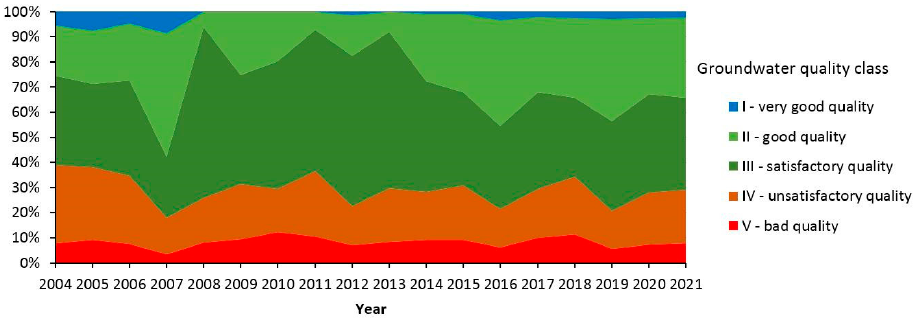
Figure 3. Time-related results of groundwater quality monitoring, quality classes according to [73,74], data obtained from [75].